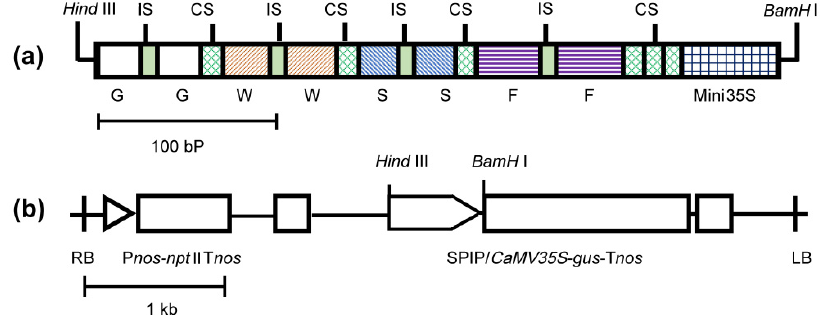
Figure 1. A diagrammatic sketch of GWSF in figure ( a ) and recombinant pB I121 harboring SPIP in ( b ) [7]. G: Gst1-box (5 ′ -TTCTAGCCACCAGATTTGACCAAAC-3 ′ ) [22]; W: W-box (5 ′ -TTATTCAG CCATCAAAAGTTGACCAATAAT-3 ′ ) [23]; S: S-box (5 ′ -CAGCCACCAAAGAGGACCCA GAAT- 3 ′ ) [24]; F: F-box (5 ′ -TTGTCAATGTCATTAAATTCAAACA TTCAACGGTCAATT-3 ′ ) [25]; IS: 6 bp